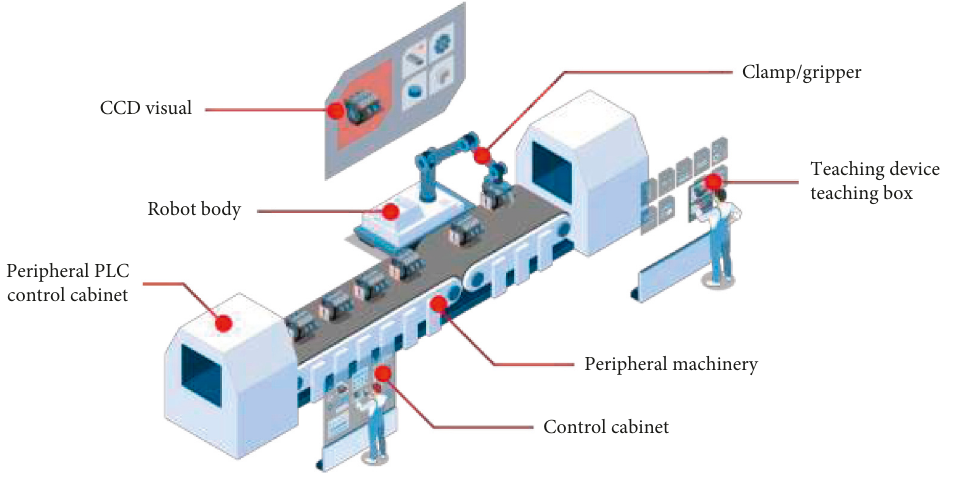
Figure 4: System composition of an industrial